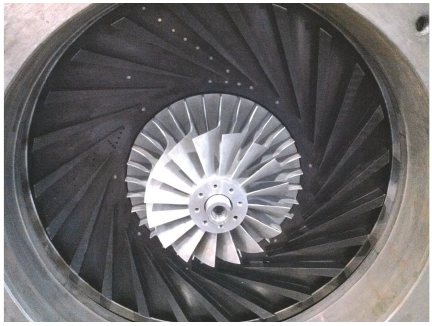
Figure 4: A photo of the test impeller and